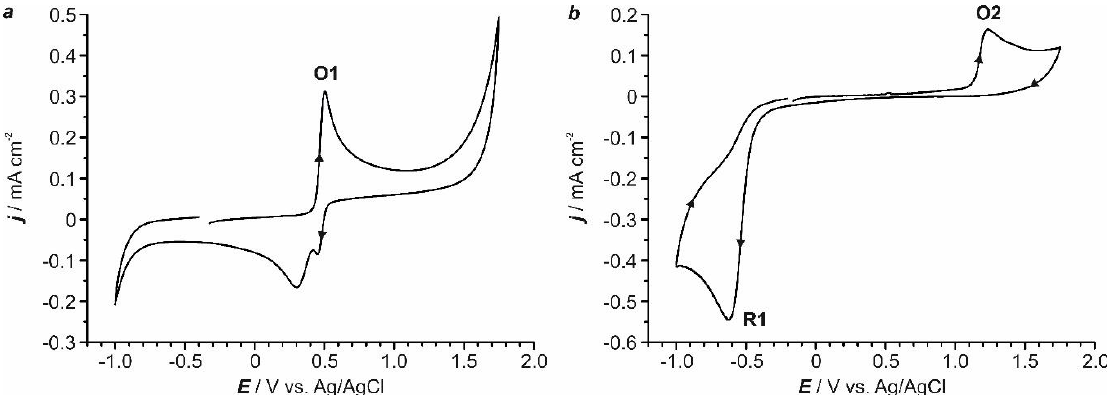
Figure 5. Cyclic voltammograms, started towards positive potentials, for a 0.6 mM aqueous solution of 4-AP ( a ) and 4-NP ( b ) (0.1 M Na 2 SO 4 ) at pH = 2.0 under quiescent conditions. In both instances, the voltammogram was recorded on a GC electrode and the scan rate was 50 mV s −1 .